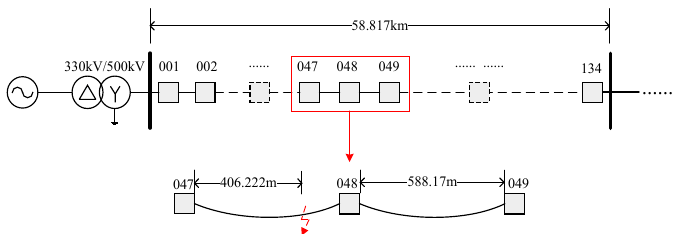
Figure 9. Schematic diagram of the 500 kV transmission line in terms of electrical distance.